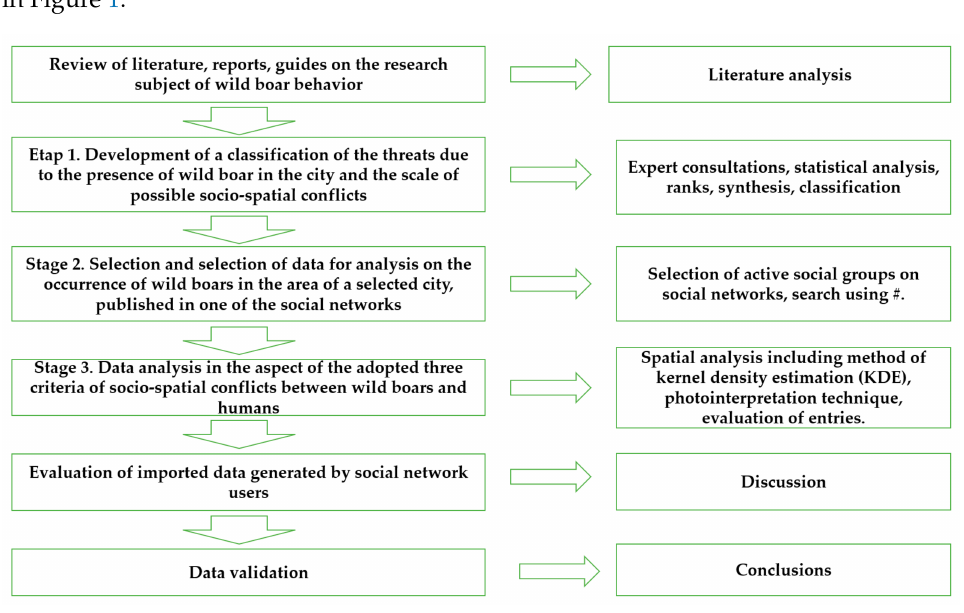
Figure 1. Diagram of research methods and tasks. Source: the